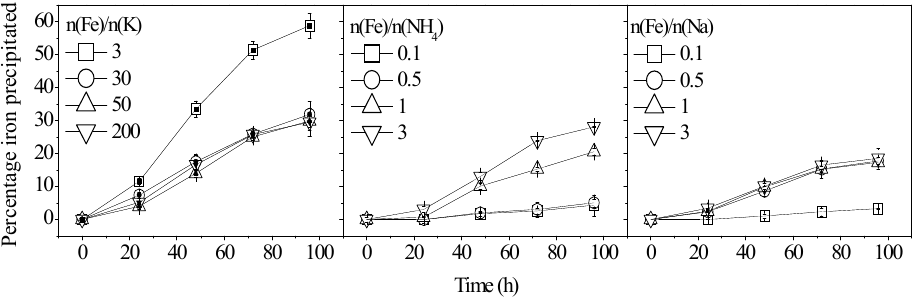
Figure 2. Effect of n(Fe)/n(M) (M: K, NH 4 , Na) on the total Fe precipitation efficiency.